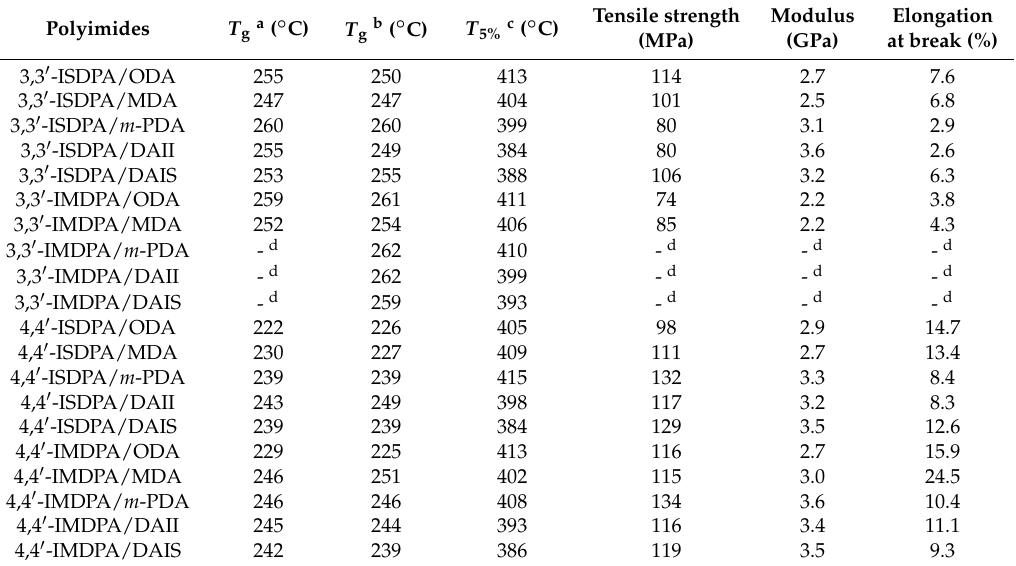
Table 2. Thermal and mechanical properties of isohexide-derived PEIs.